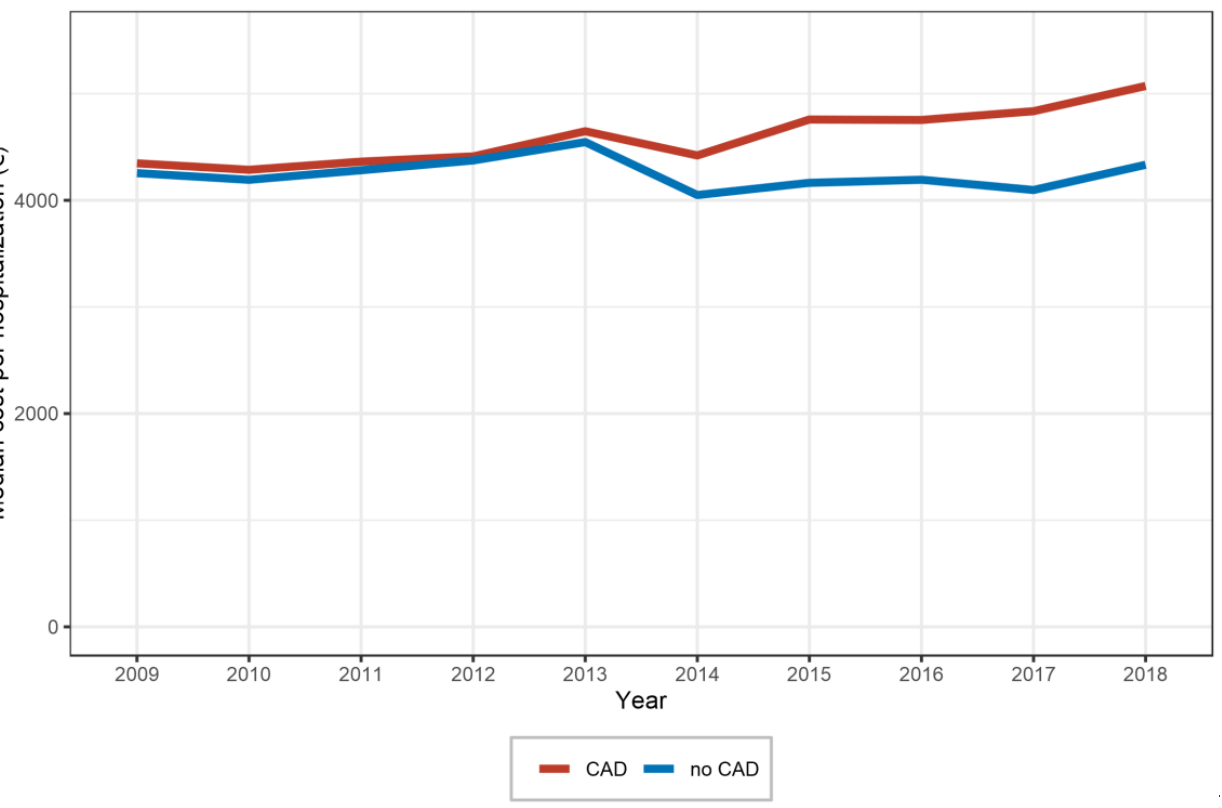
Figure 2. Median costs of hospitalizations for peripheral artery disease with and without concomitant coronary artery disease (CAD) in Germany between 2009 and 2018. 144 Table 1. General characteristics of patients admitted for peripheral artery disease with and without 145 coronary artery disease between 2009 and 2018. 146